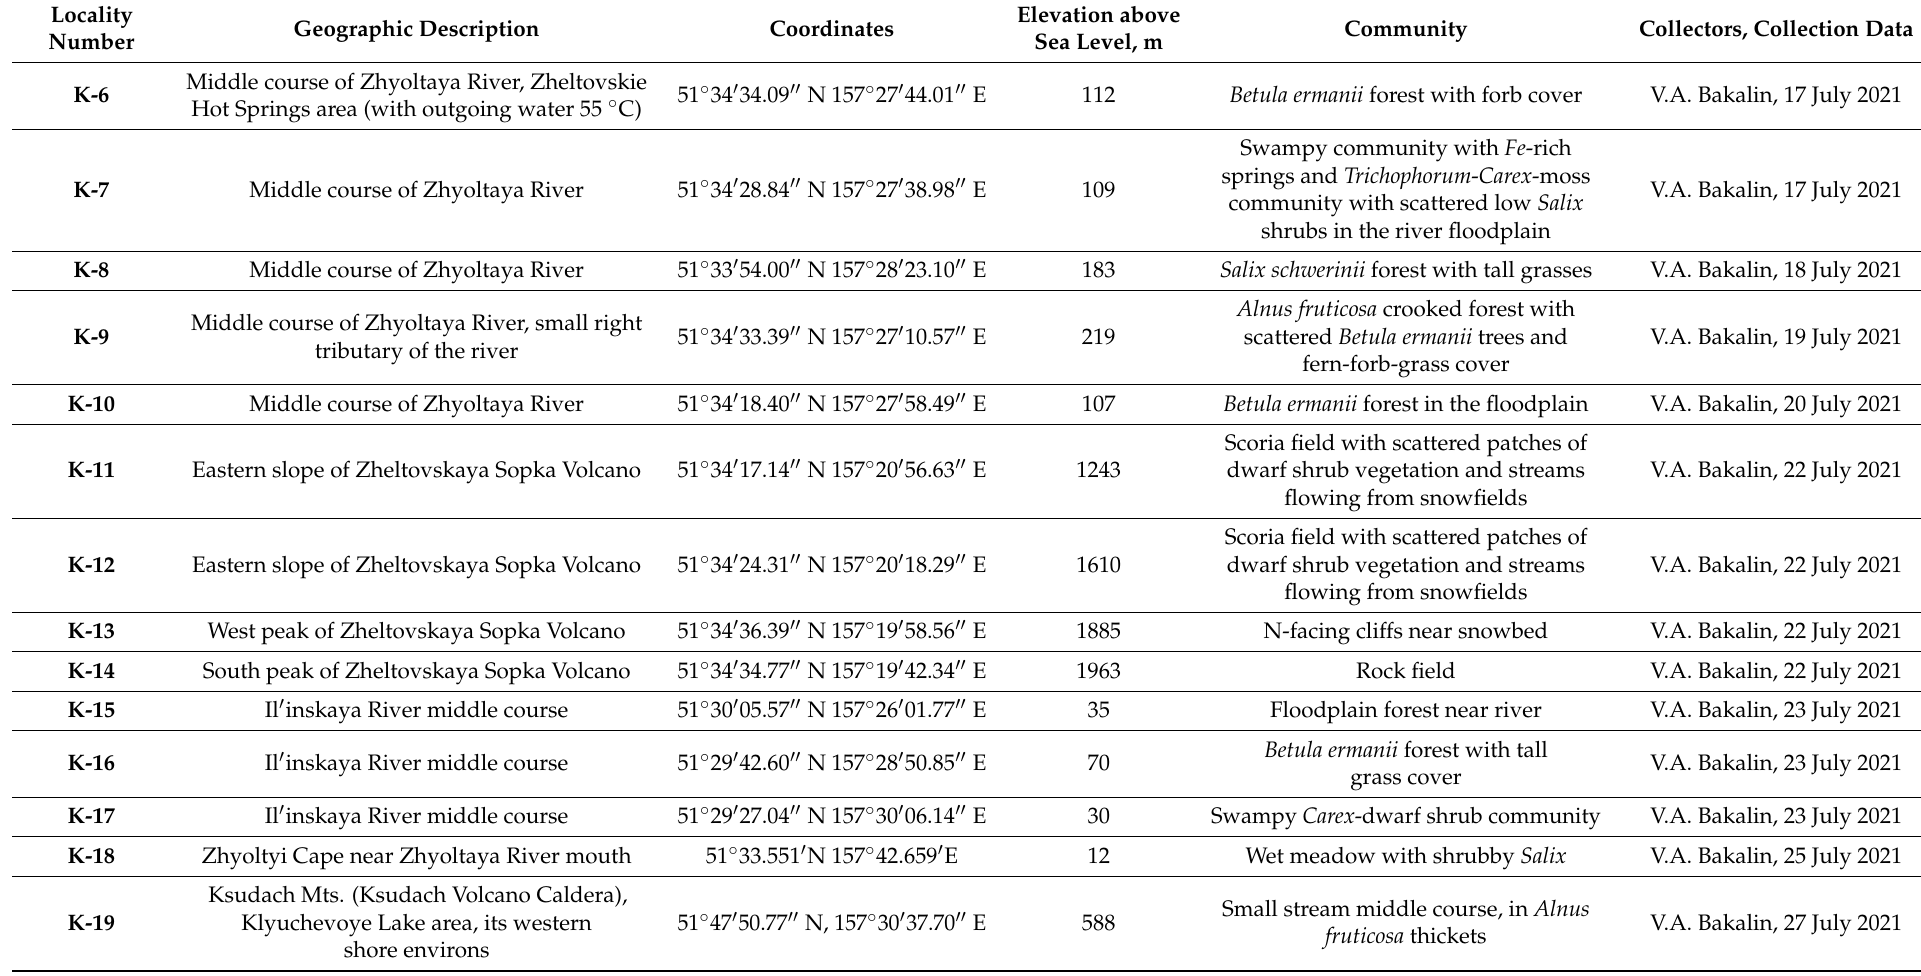
Table 1. The collecting